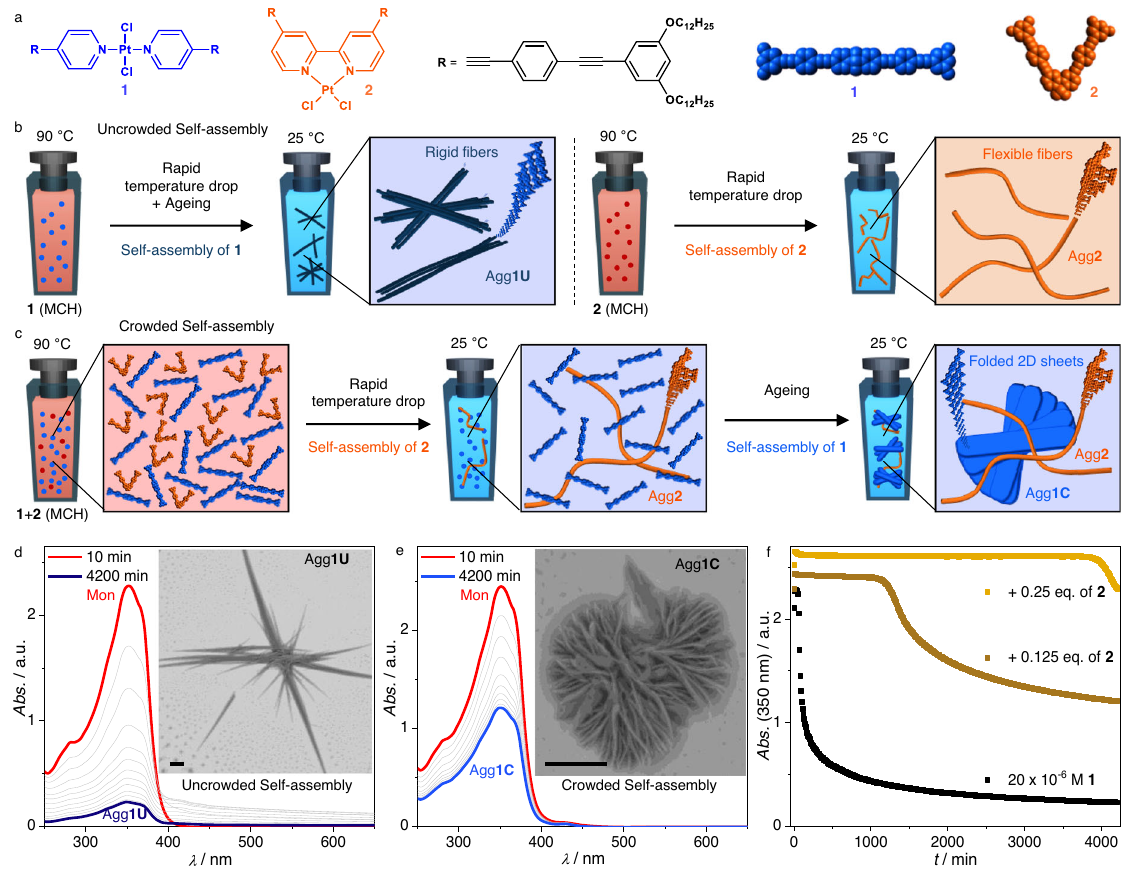
Fig. 2 | Supramolecular polymerisation of 1 in uncrowded and crowded envir- onments. a chemical structures of 1 and 2 . b schematic representation of the self- assembly behaviour of 1 and 2 in isolation. c schematic representation of the self- assembly behaviour of 1 in a crowded environment. Time-dependent UV/Vis